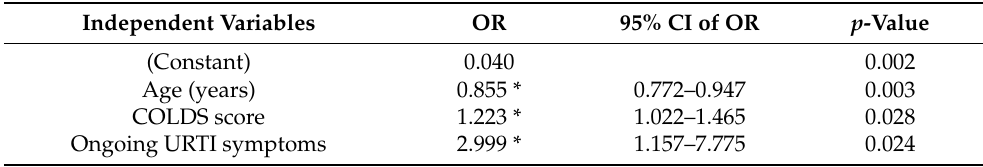
Table 1. Logistic regression results for the occurrence of perioperative respiratory adverse events (PRAEs) regarding age, COLDS score, and ongoing URTI symptoms.